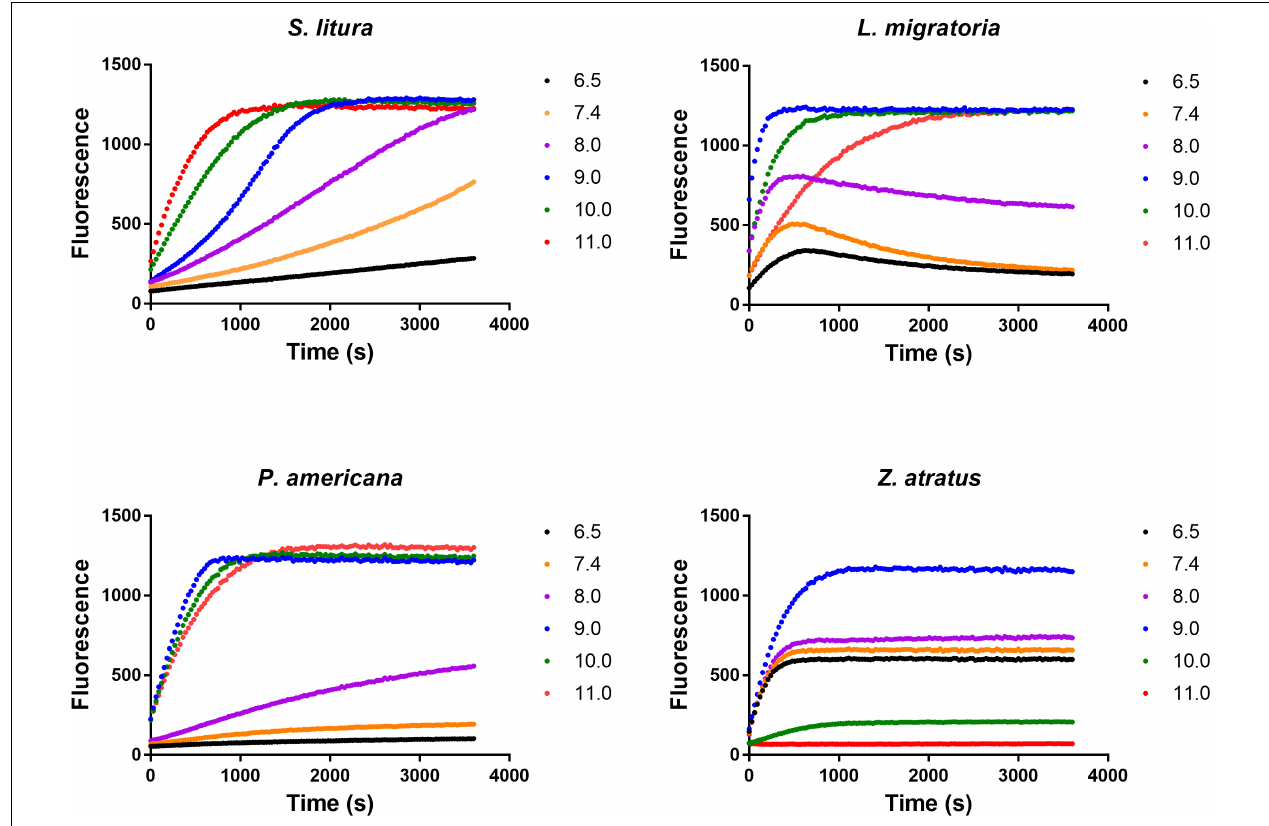
FIGURE 5 | Distinct impacts of pH on the dsRNA degrading nucleases of four insects. The homogenates were prepared from whole body of different insects. The reaction buffer containing 0.1 M Glycine, 0.1 M NaCl, 1 mM MgCl 2 , 1 mM PTU, 1 mM DTT, 1 mM PMSF and 10% Glycerol was adjusted by KOH to different pH (6.5, 7.4, 8.0, 9.0, 10.0, and 11.0). Each reaction containing 19 µ L enzyme solution and 1 µ L fluorescence labeled dsRNA substrate at a final concentration of 0.5 µ M. The fluorescence intensity in different reactions were continuously monitored at 37 ◦ C. Values are mean of fluorescence intensity; n =